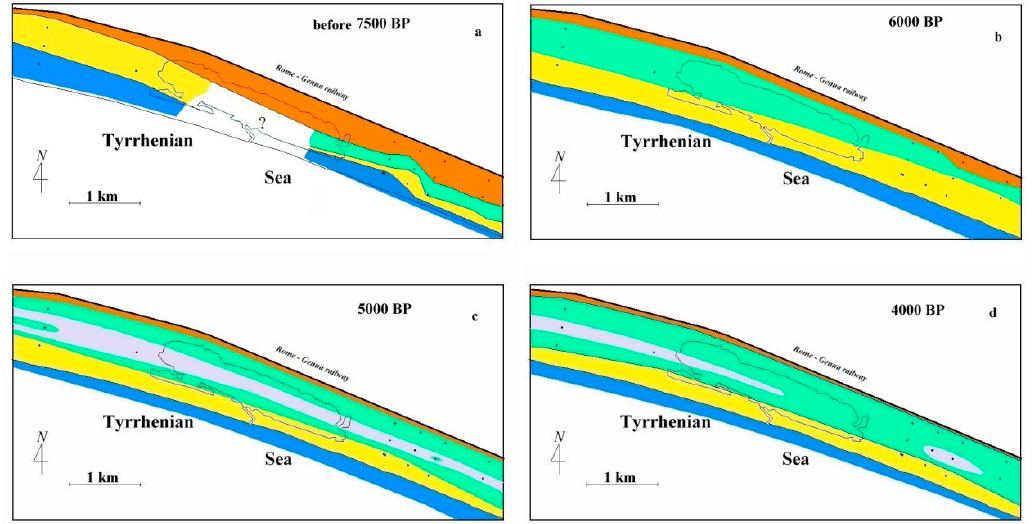
Figure 8. Schematic bidimensional landscape reconstructions of the Burano paleo-lagoon from 7500 to 4000 years BP ( a – d ). Coloured areas indicate: Pleistocene deposits (brown), lagoon/marsh Holocene deposits (green), Holocene sandy barrier and foreshore deposits (yellow), Holocene lacustrine deposits (grey), Holocene shoreface deposits (blue). The location of Burano Lake and the present shoreline is indicated.